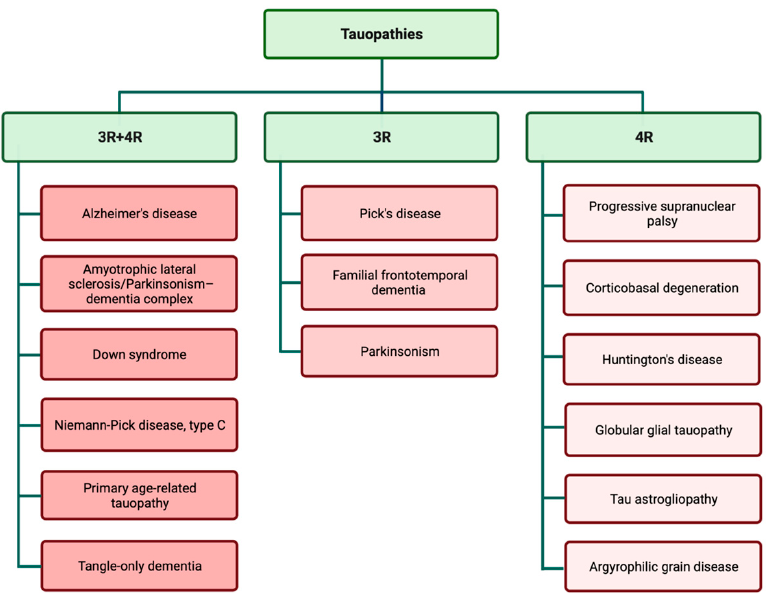
Figure 2 . Tauopathies are classified according to the presence of 3R and 4R isoforms in tau inclu-